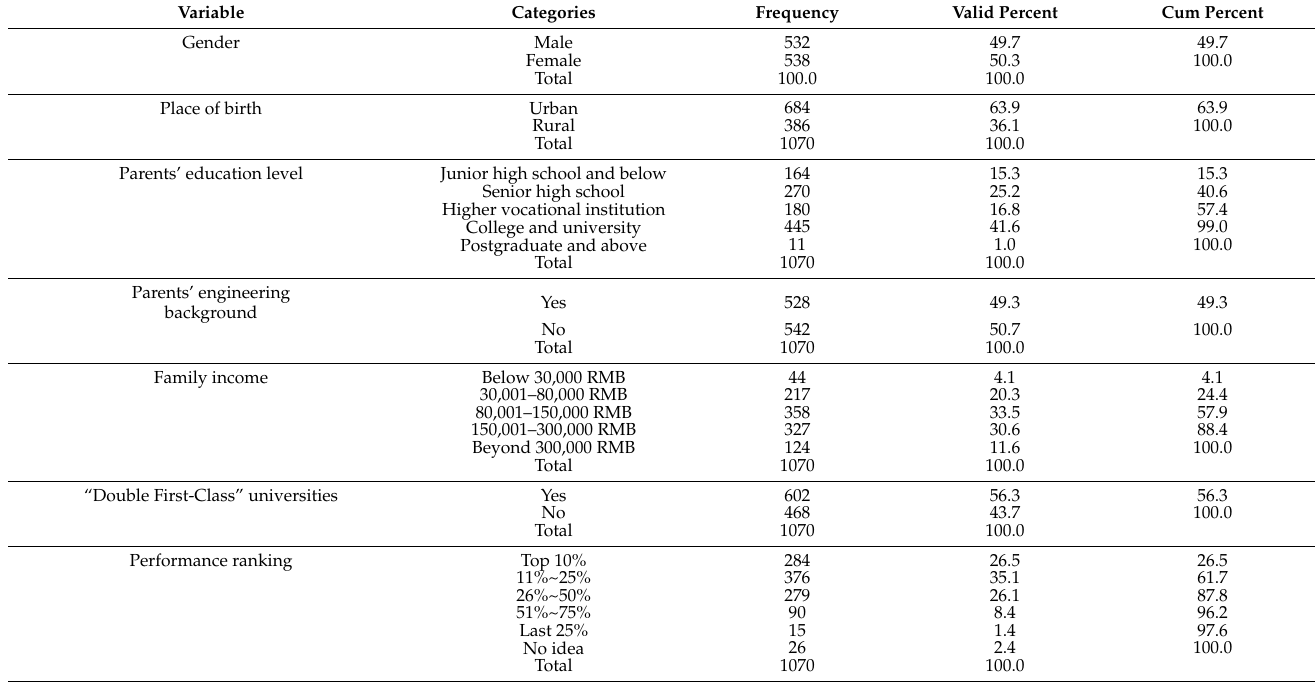
Table 1. Results of statistical analysis of subjects (n =